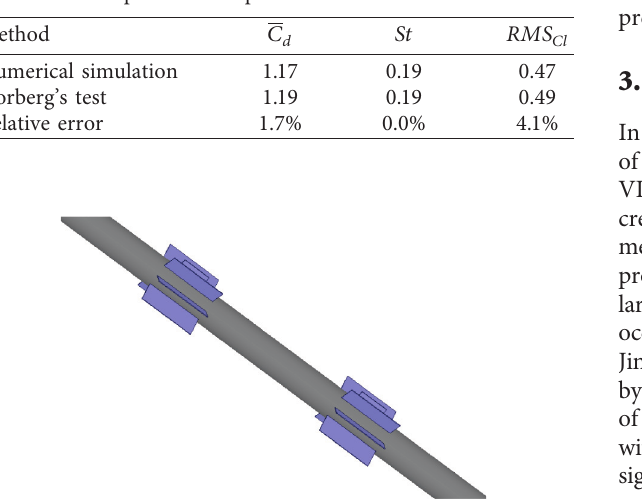
Figure 5: PSD of lift Table 1: Comparison of experimental and numerical results.